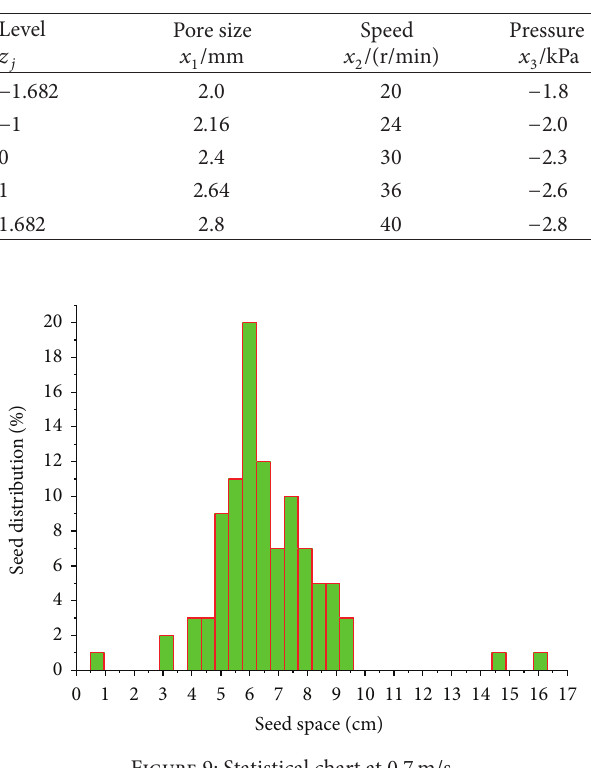
Figure 9: Statistical chart at 0.7 m/s.